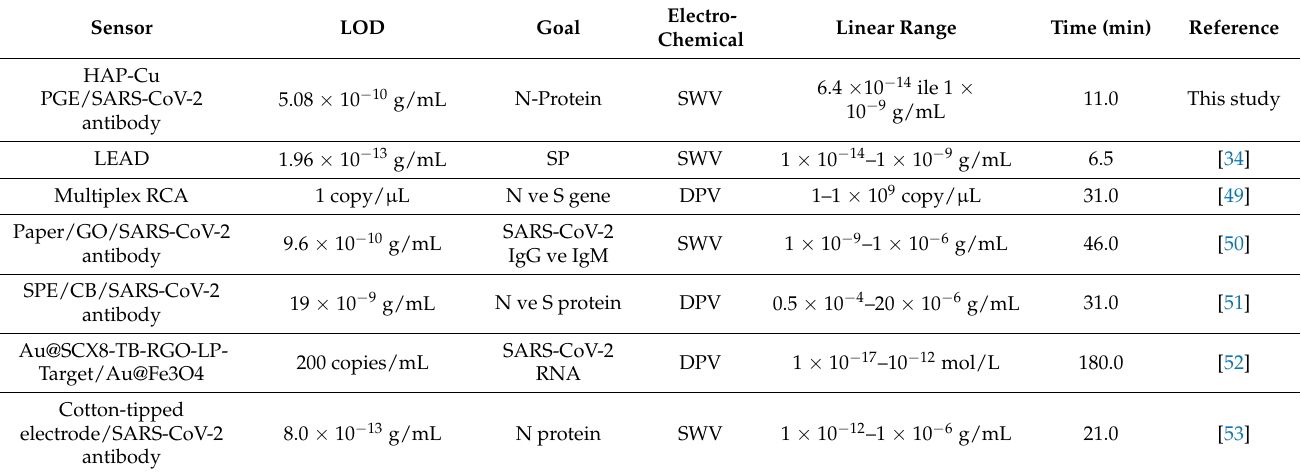
Table 2. Comparison with previously developed electrochemical SARS-CoV-2 sensors in the